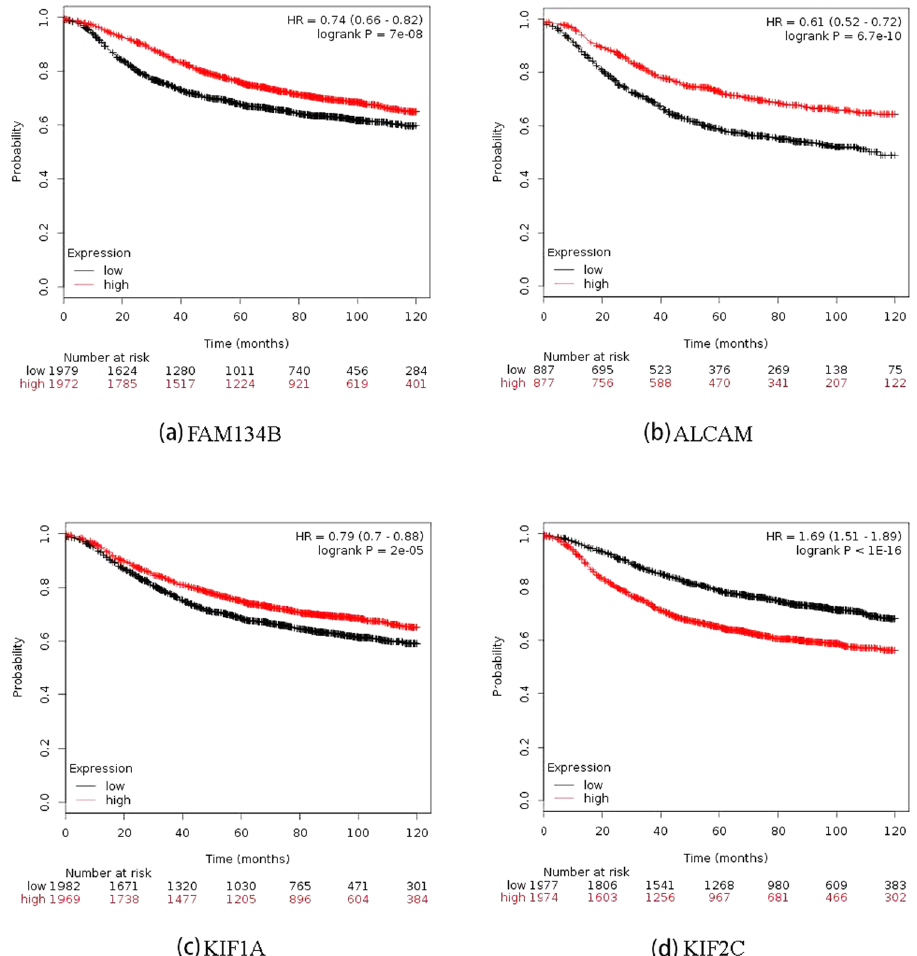
Figure 5. Breast cancer patient 10-year relapse free survival associated with each of the four pivotal diagnostic genes computed from Kaplan Meier